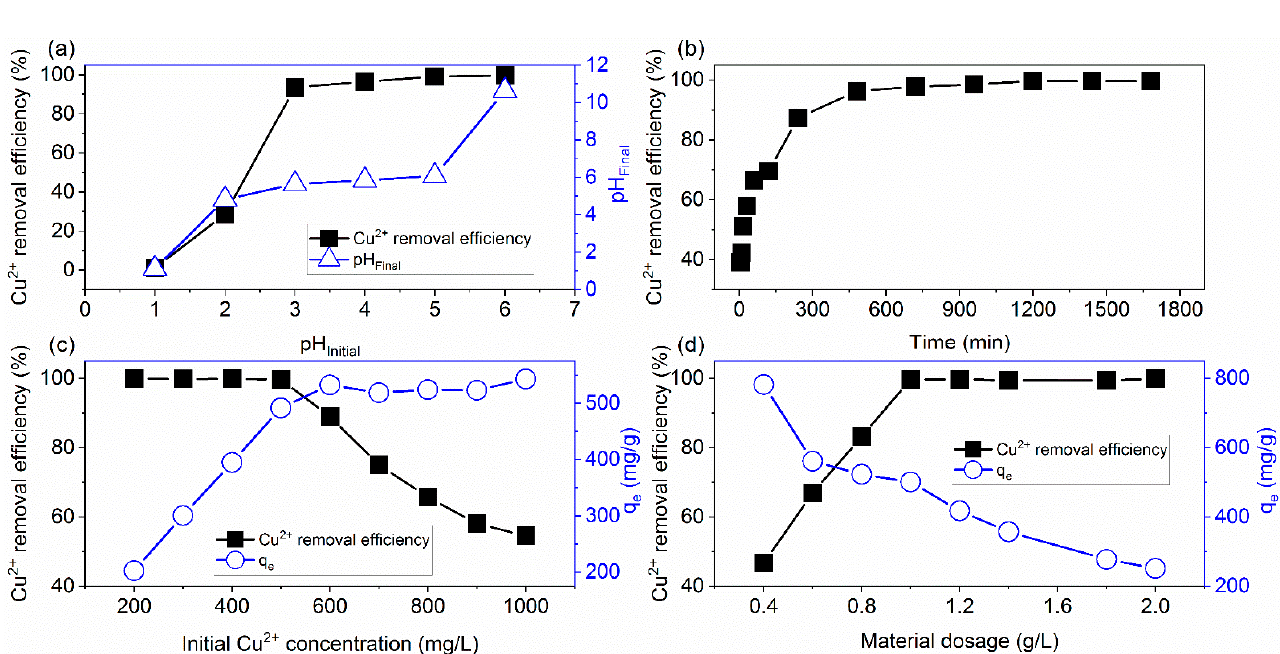
Figure 2. ( a ) The relationship between Cu 2+ removal, final solution pH, and the initial pH. ( b ) The effect of reaction time on Cu 2+ removal. ( c ) The relationship between Cu 2+ removal and its initial concentration. ( d ) The evolution of Cu 2+ removal ability with the dosage of AmCalA.